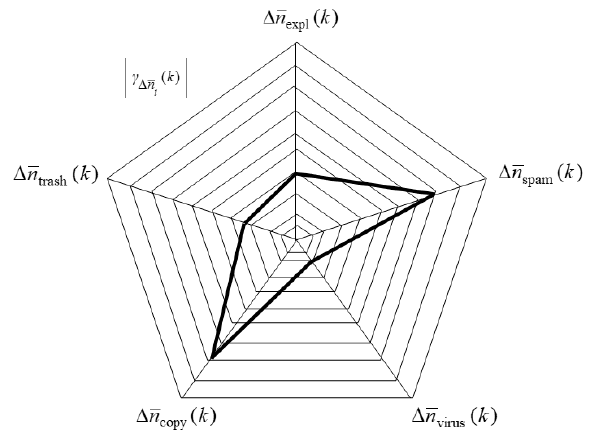
Figure 4. The circular radar chart of the results of experimental calculations of the sensitivity functions values for filtering algorithms for a group of harmful information indicators, which has a negative impact on cybernetic and physical subsystems of cyber physical systems (CPS).